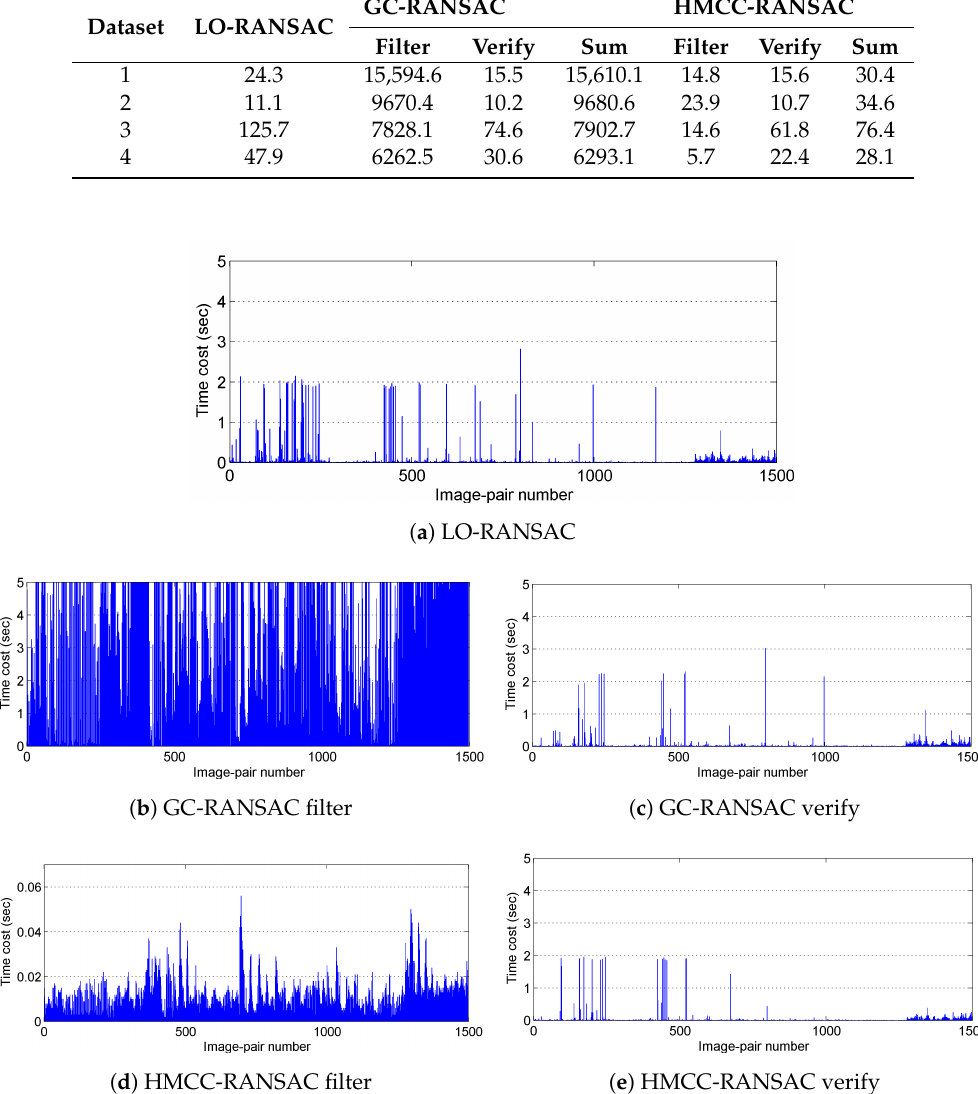
Figure 11. Efficiency comparison of individual image pair: ( a ) LO-RANSAC; ( b , c ) GC-RANSAC; ( d , e )